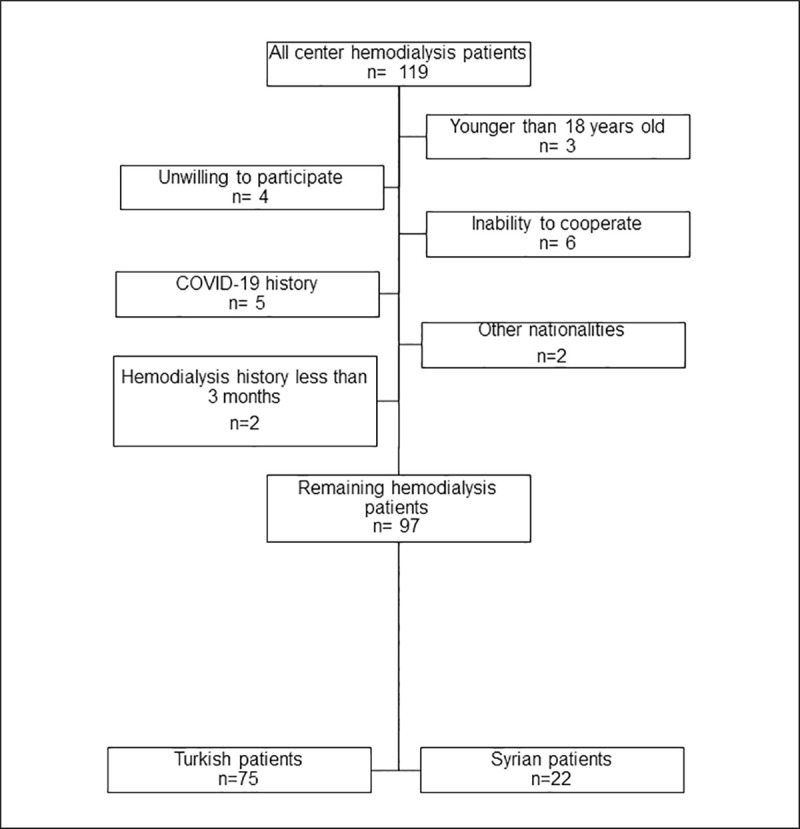
Details of the patient cohort.After enrollment of all center hemodialysis patients (n = 119), 22 patients were excluded due to following reasons: unwilling to participate (n = 4), younger than 18 years old (n = 3), inability to cooperate (n = 6), COVID-19 history (n = 5), hemodialysis history less than 3 months (n = 2), other nationalities (n = 2). Seventy-five Turkish, 22 Syrian patients’ data were analyzed further.